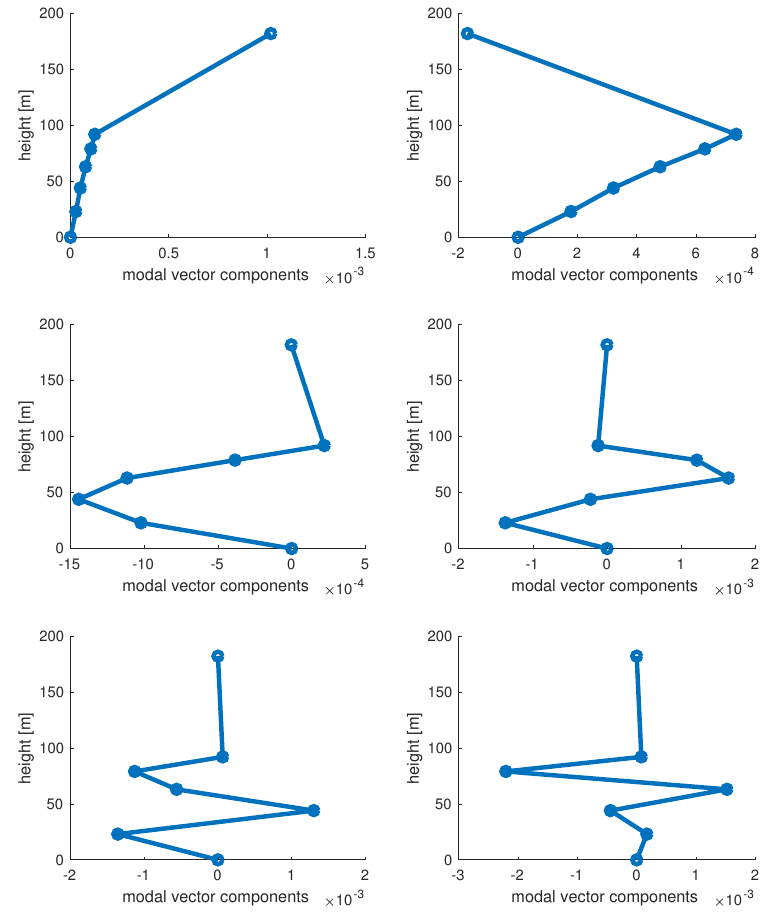
Figure 19. Mooring line vibrational